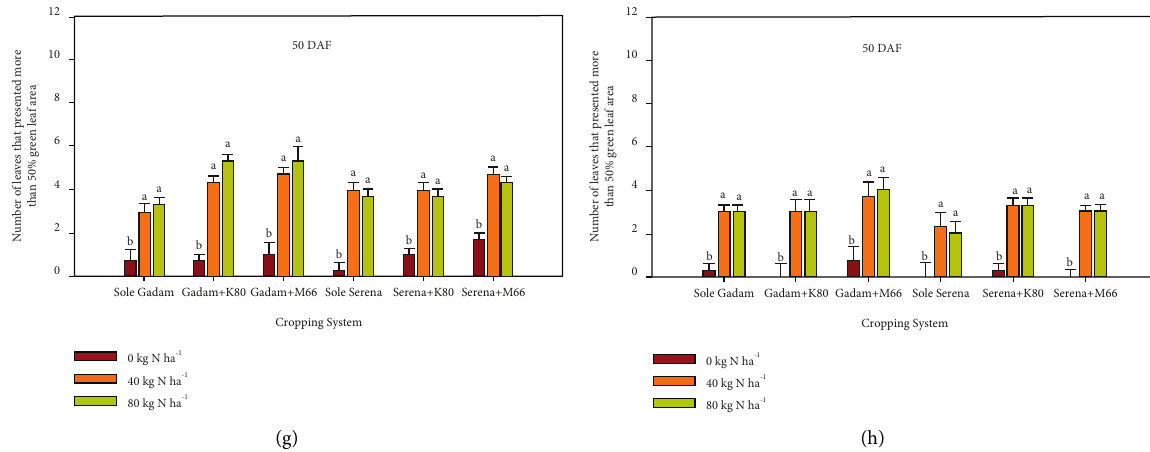
Figure 2: Number of leaves that presented more than 50% green leaf area at 10, 20, 40, and 50days after flowering (DAF) of two sorghum varieties (Gadam and Serena) grown in sole and intercrop system with two varieties of cowpea (K80 and M66) and interactions with 0, 40, and 80kg · N · ha − 1 at the KALRO research stations in Igoji (a, c, e, g) and Katumani (b, d, f, h) during 2018/2019 short rains season. Mean values followed by the same letter are not significantly different. The bars indicate the mean standard errors